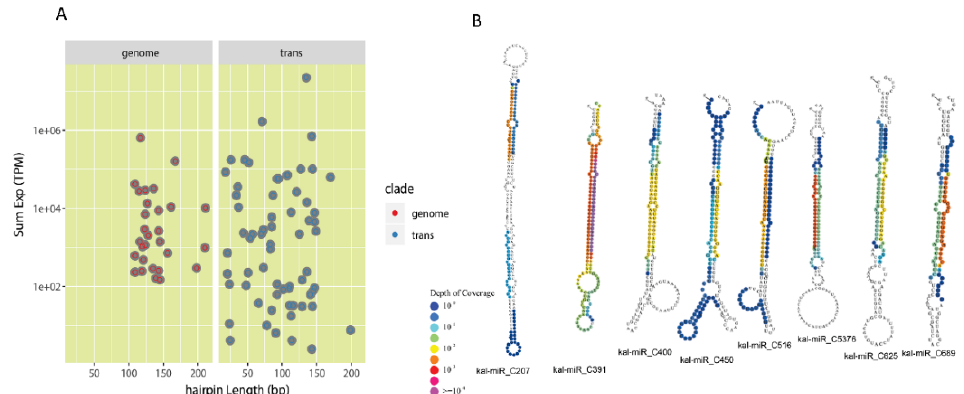
Figure 2. Identification of miRNAs based on small RNA sequencing. ( A ) The distribution of miRNAs by using genome (red dots) and transcriptome (blue dots) as the references, respectively. ( B ) Novel miRNAs identified in Kalanchoë that are not homologous in other plant lineages. Different colors of each base indicate the depth of coverage of small RNA sequencing reads that are mapped to the precursor. The plot is made by strucVis version-0.4 (https://github.com/MikeAxtell/strucVis, accessed on 19 June 2018).